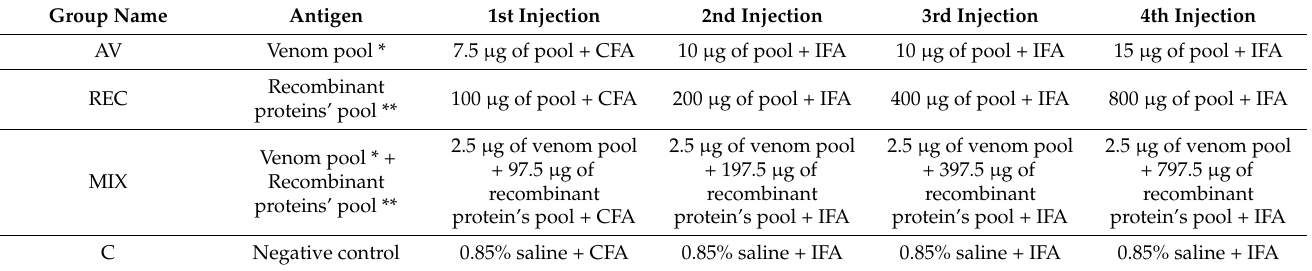
Table 1. Protocol to produce